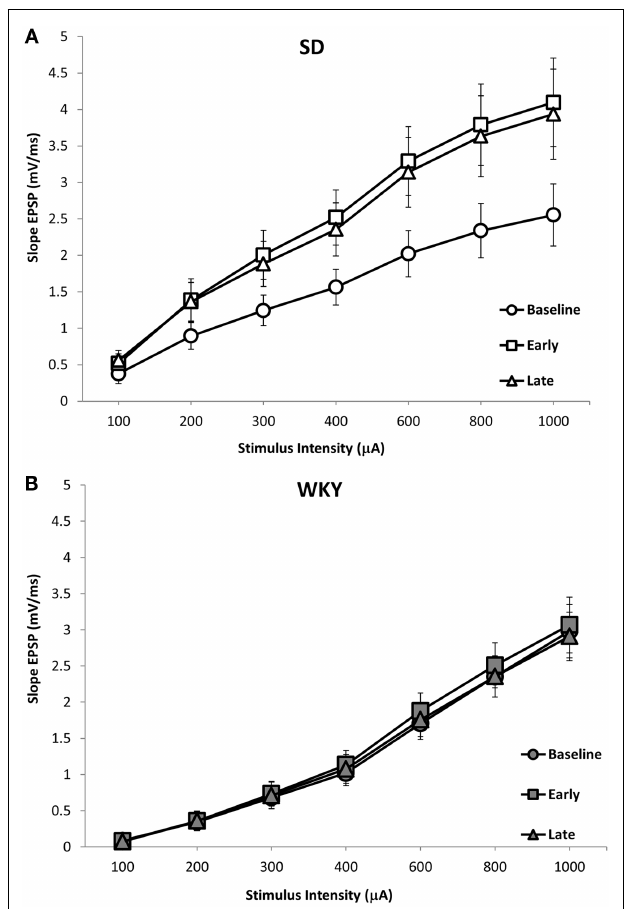
FIGURE 7 | LTP of the dentate gyrus population spike following HFS of the medial perforant pathway in SD andWKY rats . Following HFS, SD rats exhibited robust early and late phase LTP of the population spike (A) . In contrast to SD rats, early or late phase LTP of the population spike was not observed inWKY rats (B)